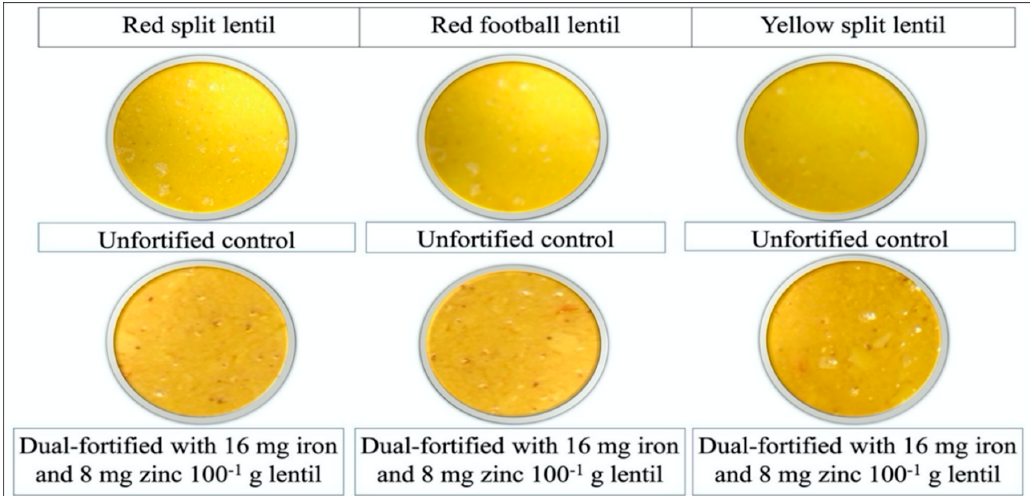
Figure 2. Samples of cooked dal prepared from each of the three product types (red split, left column; red football, middle column; and yellow split, right column) of lentil, including the unfortified controls ( upper three ) and dual-fortified samples ( lower three ) fortified with 16 mg of Fe and 8 mg of Zn 100 − 1 g of lentil.